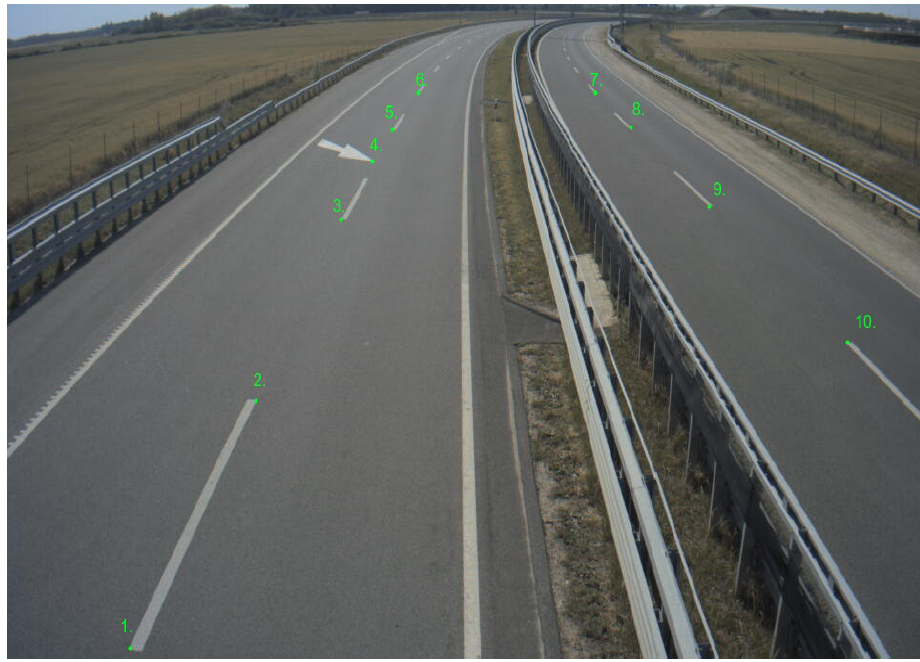
Figure 31. Points used to calculate homography matrix.